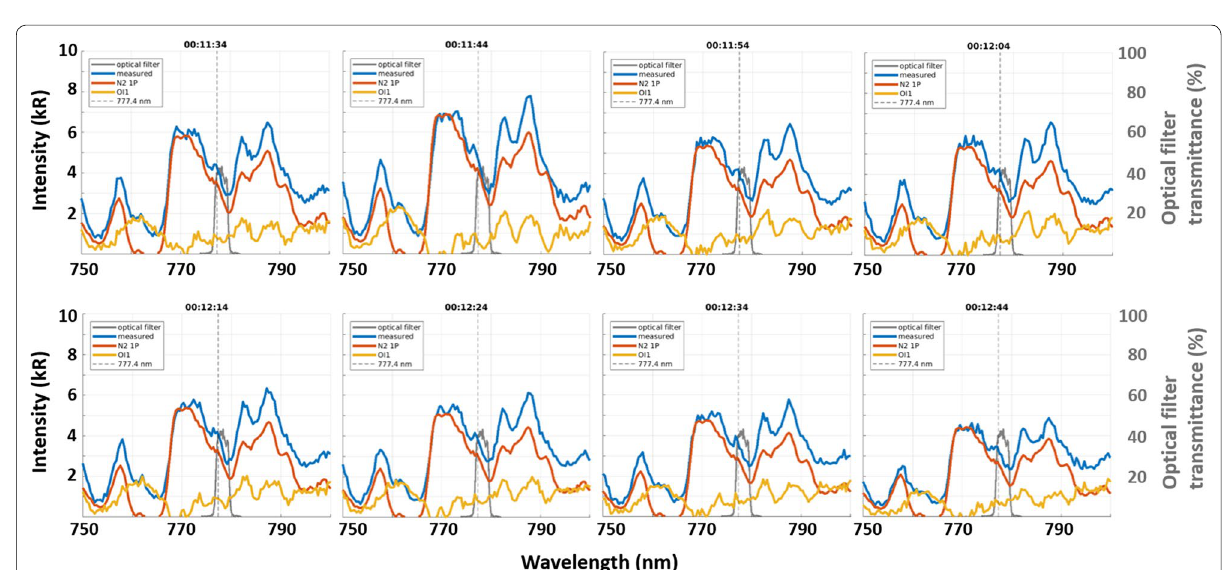
Fig. 2 Eight spectra that were measured with the spectrograph at wavelengths of 750–800 nm from 00:11:34 to 00:12:44 UT on March 2, 2017 (blue). A vertical dashed line is marked at 777.4 nm. The orange and yellow curves are explained in the text. The transmittance of the optical filter that is mounted on the EMCCD camera in Tromsø is represented in by a gray